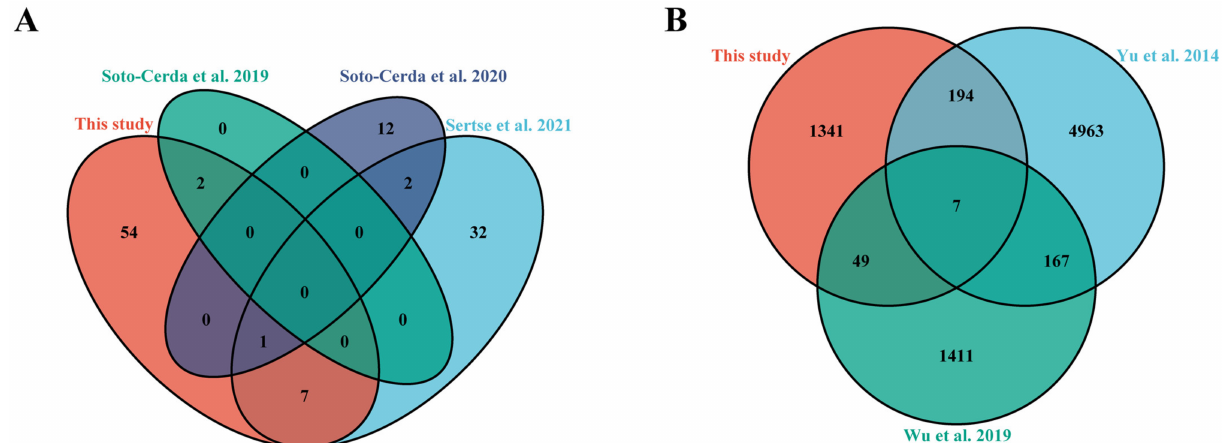
Figure 4. Compared with previous reports. ( A ) Comparison of the 64 QTLs involved in flax salt- tolerance detected in this study and the QTLs regulating drought tolerance reported previously; ( B ) Comparison of the 1591 preliminary candidate genes involved in flax salt-tolerance detected in this study and the transcriptome genes with salt stress reported previously.